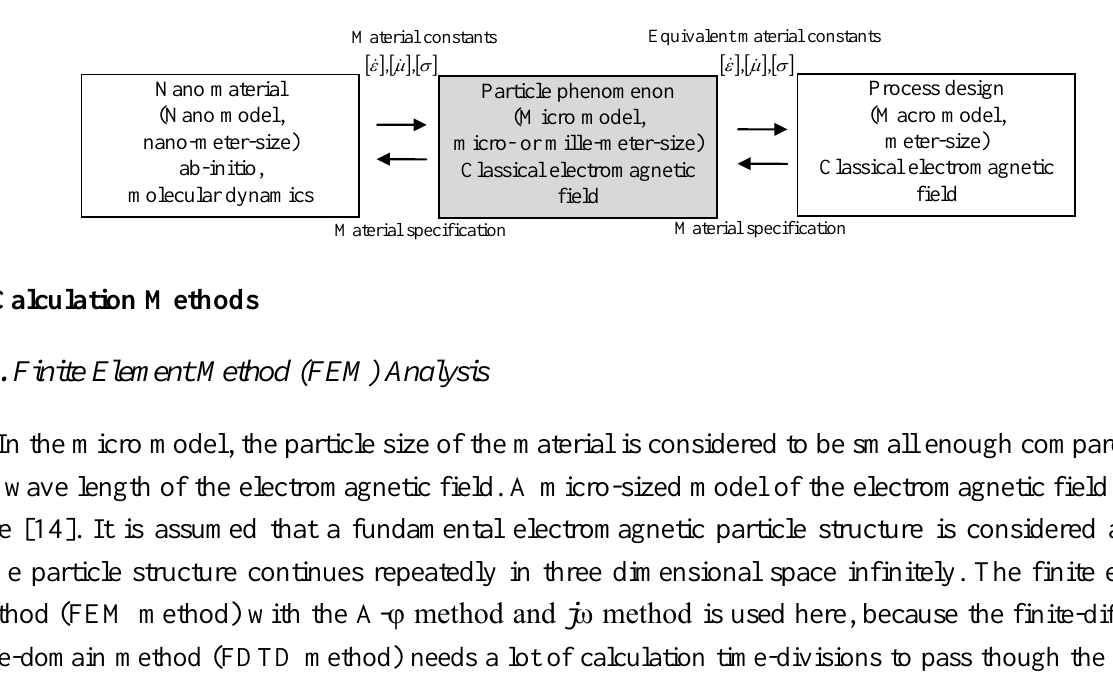
Figure 1. Multi-scale phenomenon of microwave